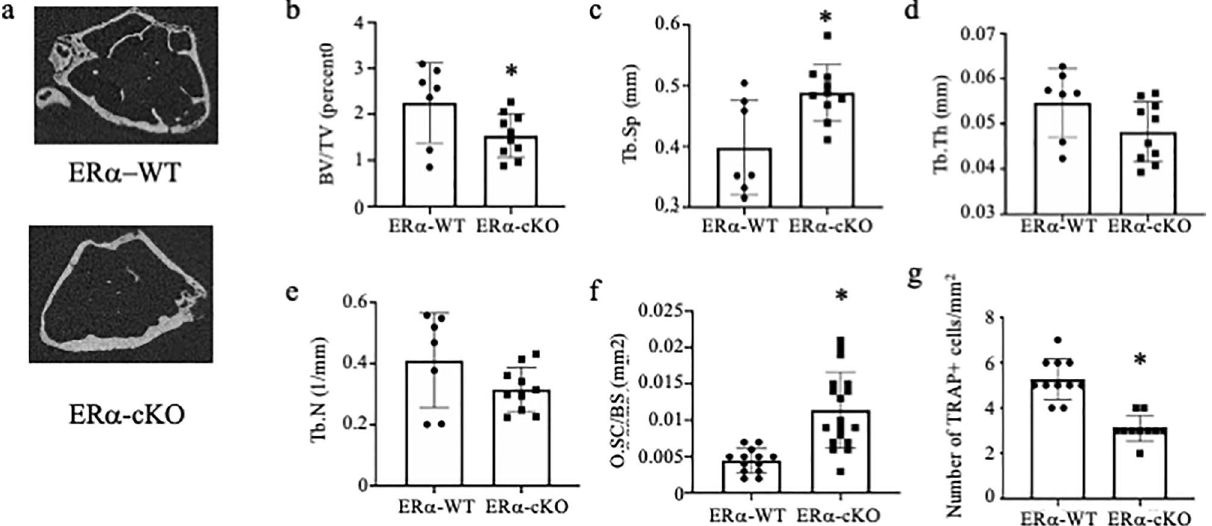
Figure 5. Female ERα-cKO mice are osteopenic at 9 months of age. ( A ) Representative images of trabecular bone in the distal metaphysis of femur ( B – E ) Trabecular micro-CT measurements of femur ( F – G ) histological measurements of ( F ) osteoclast surface area to bone surface and ( G ) osteoclast number/mm 2 *Significantly different from ERα-WT.